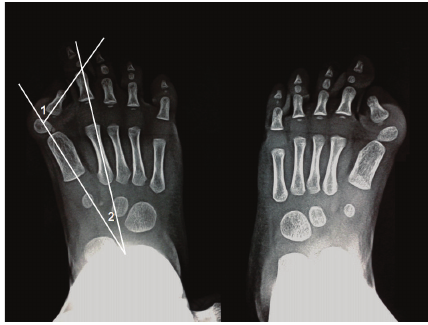
F 2: X-ray for the baby’s feet showing rudimentary proxi- mal phalanges, hallux valgus deformities with hallux valgus